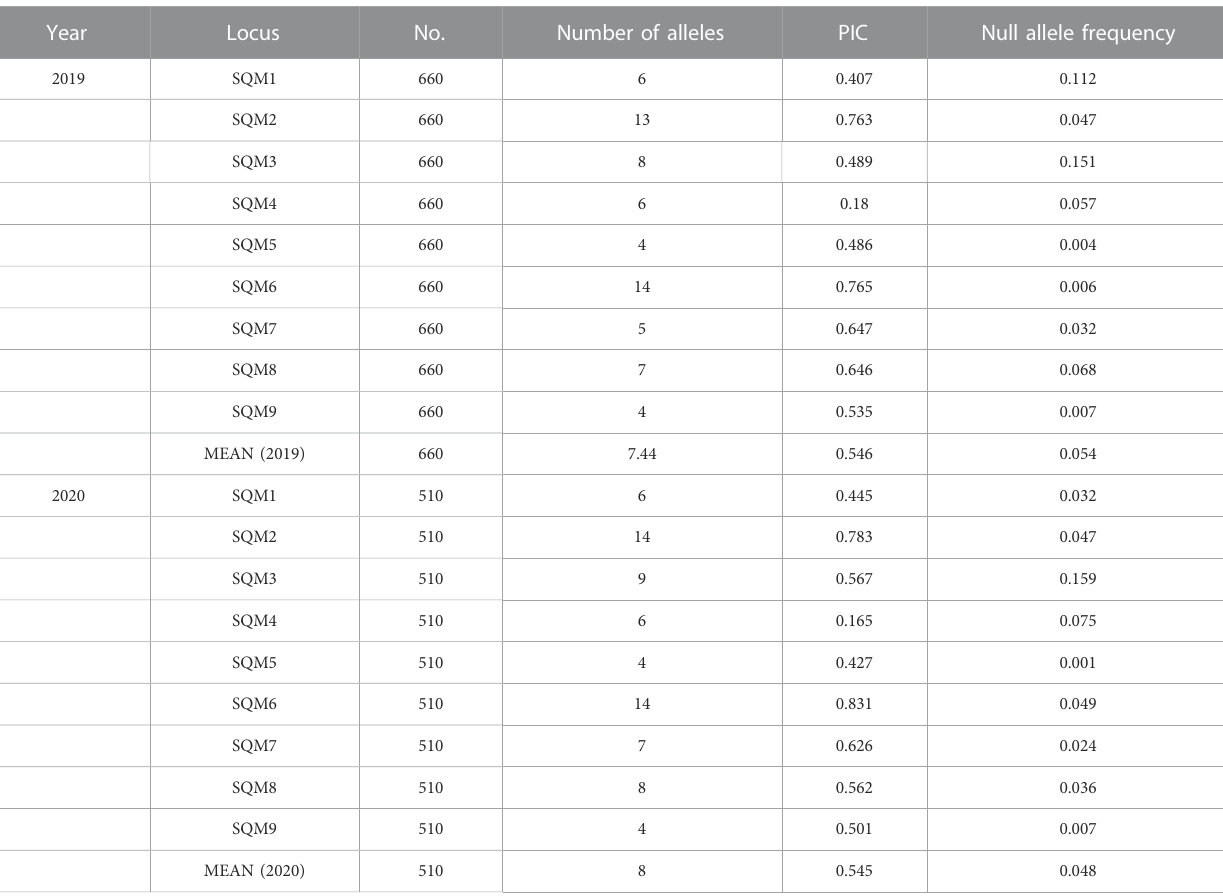
TABLE 2 Polymorphic information at nine microsatellite loci in 2019 and